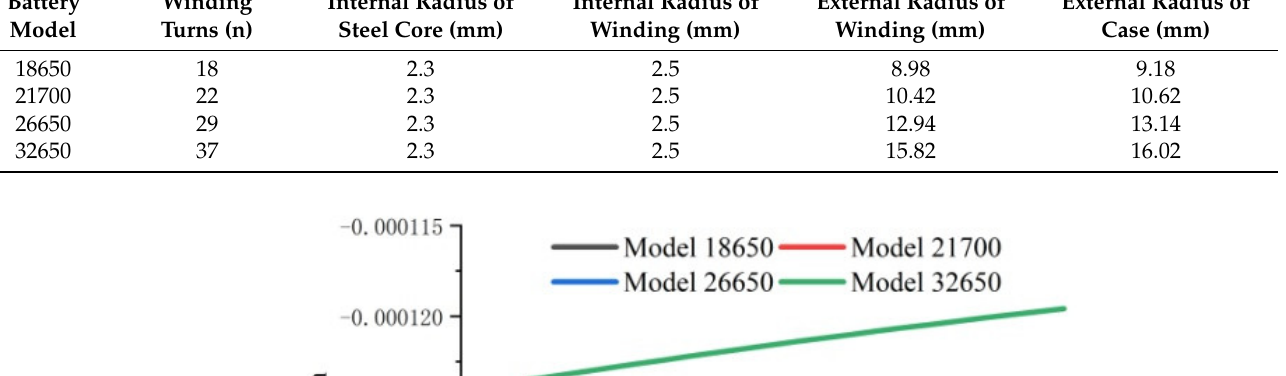
Table 2. The geometric parameters of four types of batteries.